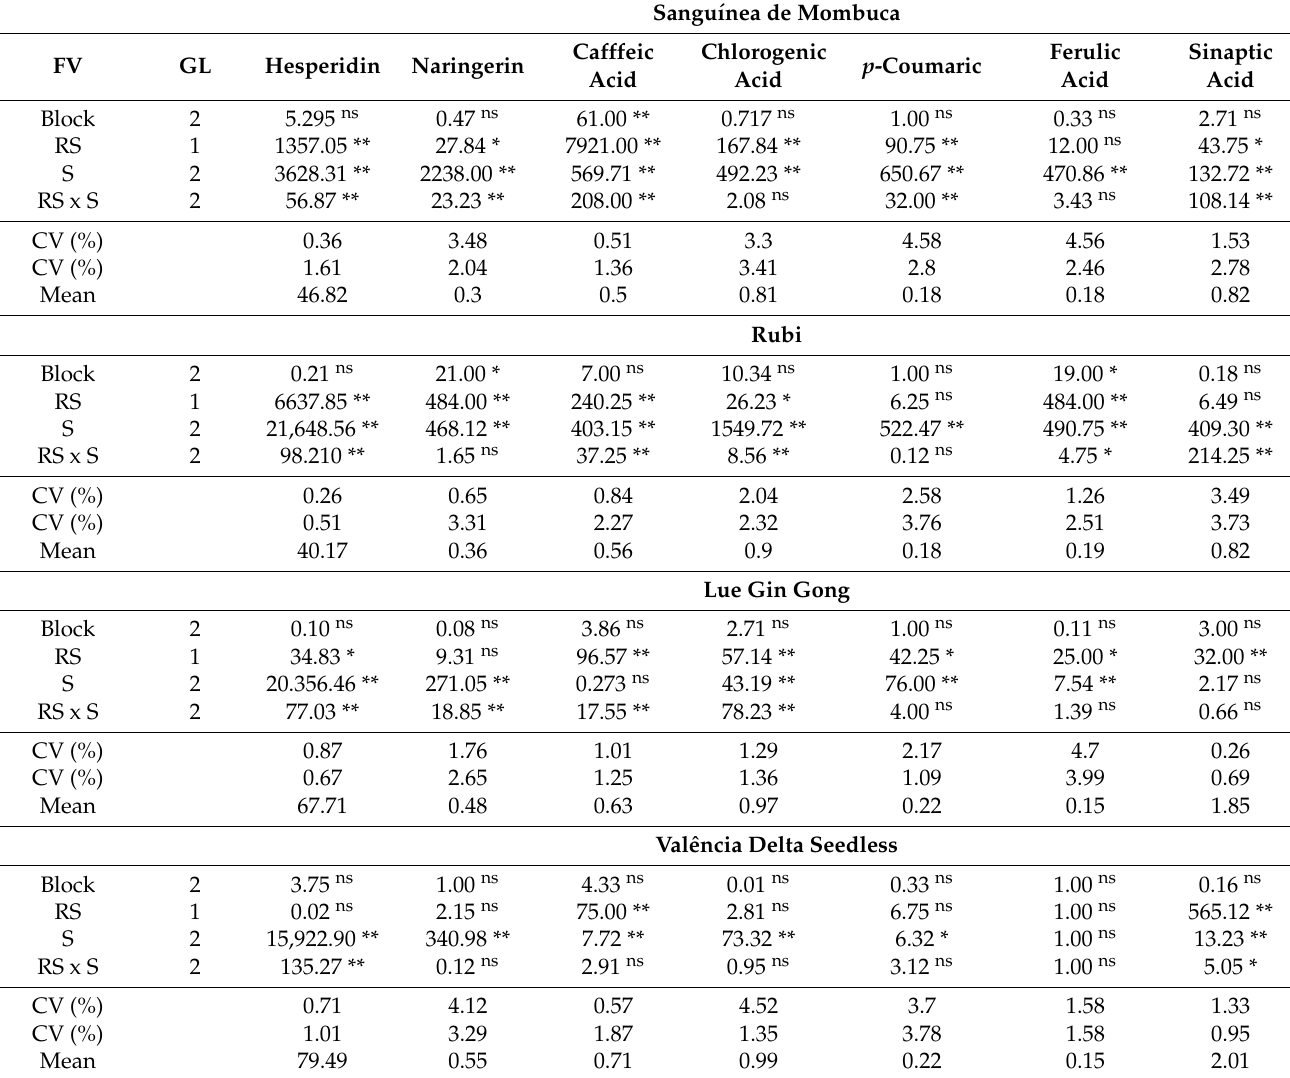
Table 3. F-values, degree of freedom (DF), and coefficient of variation (CV) of phenolic compounds in juices from different scion/rootstock combinations subjected to 35 days of